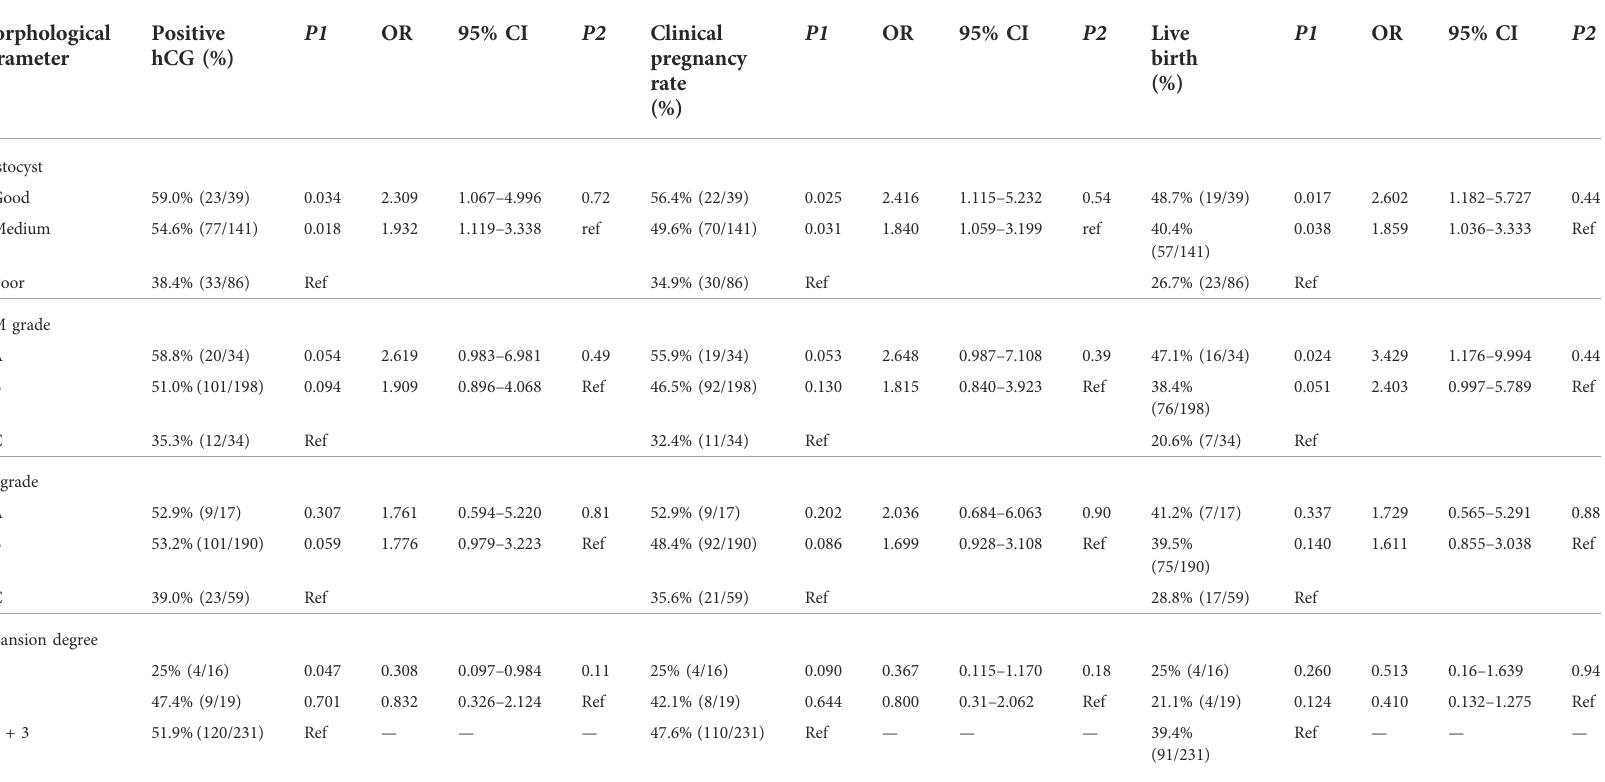
TABLE 3 Comparison of clinical outcomes of different morphological groups. Morphological